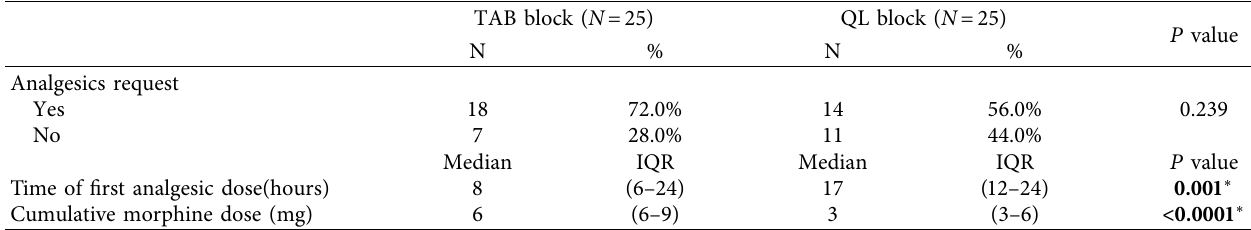
Table 2: Comparison of analgesic requirements on the 1st day among different study groups.